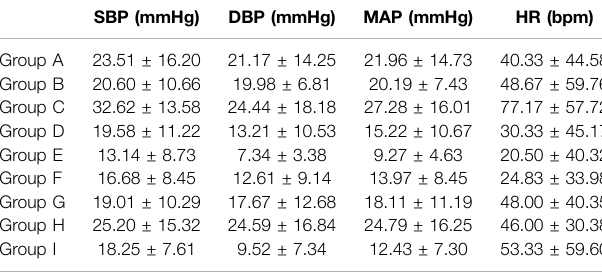
Error bars represent the mean ± SD. SBP, systolic blood pressure; DBP,diastolic blood pressure; MAP, mean arterial pressure; HP, heart rate. Group A received phenylephrine eye drops. Group B received intravenous atropine treatment. Group C received phenylephrine and atropine simultaneously. Groups D, E, and F received phenylephrine eye drops fi rst and then intravenous atropine treatment fi ve, ten, and 15 min later, respectively.GroupsG,H,andIreceivedintravenousatropinetreatment fi